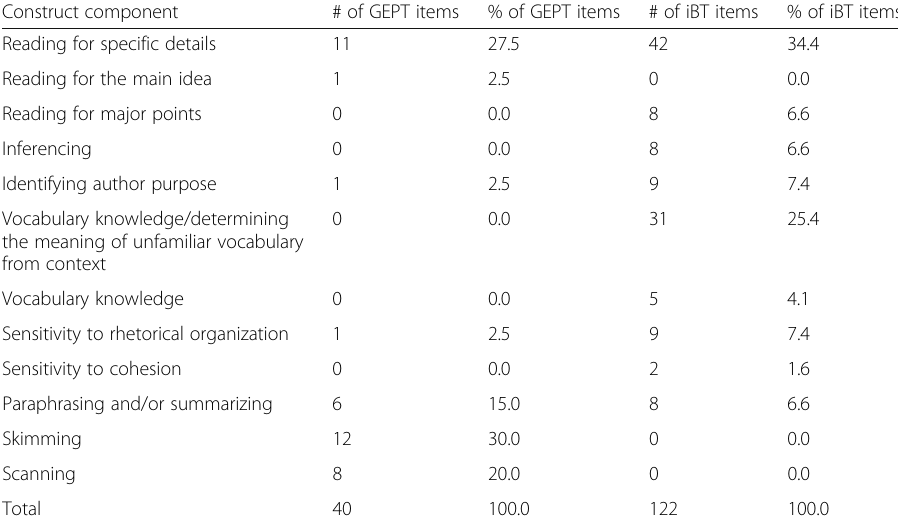
Table 3 Summary of construct coverage for the GEPT-A and iBT